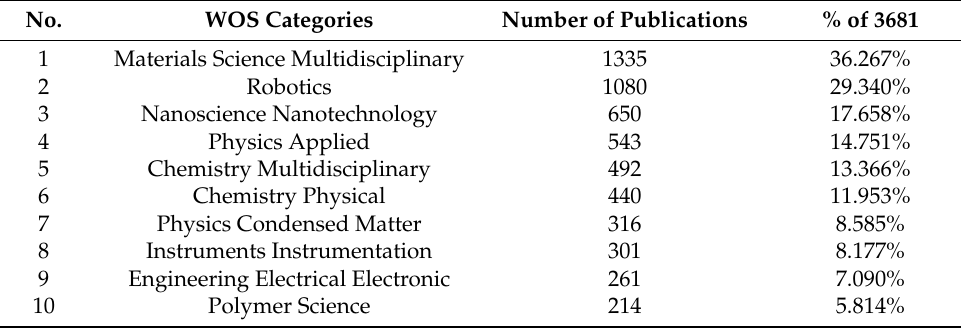
Table 1. Top 10 research areas in WOS contributing to the field of soft